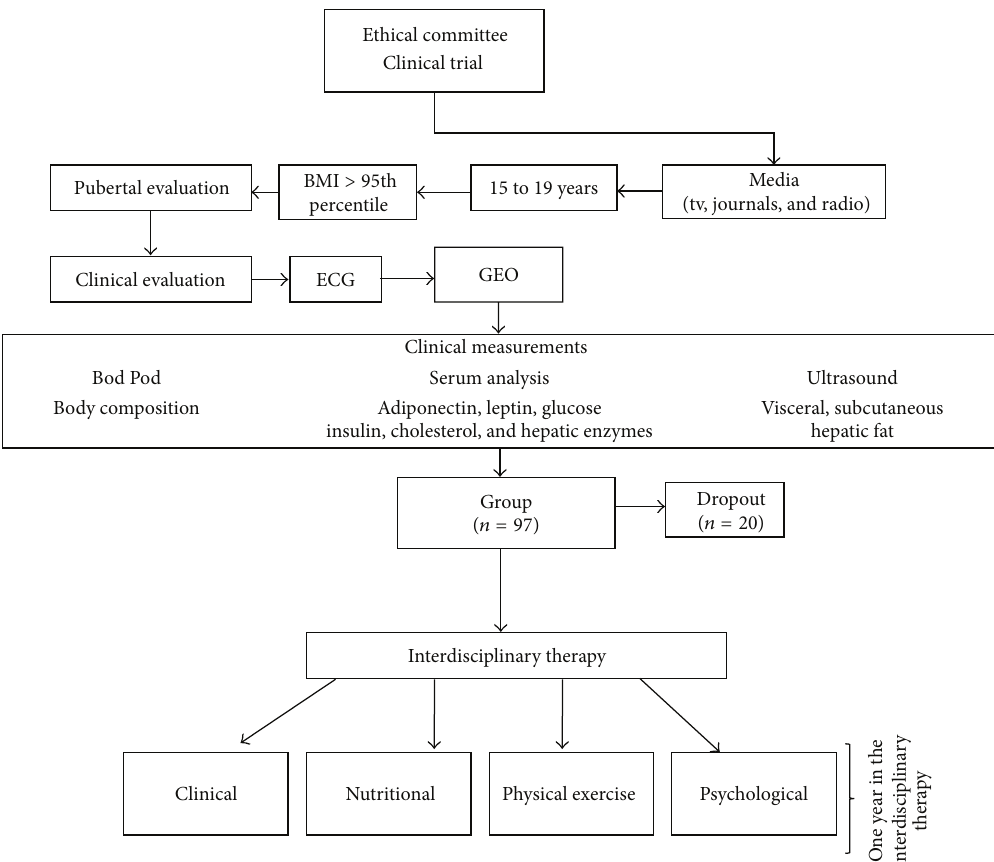
Figure 2: Methodological